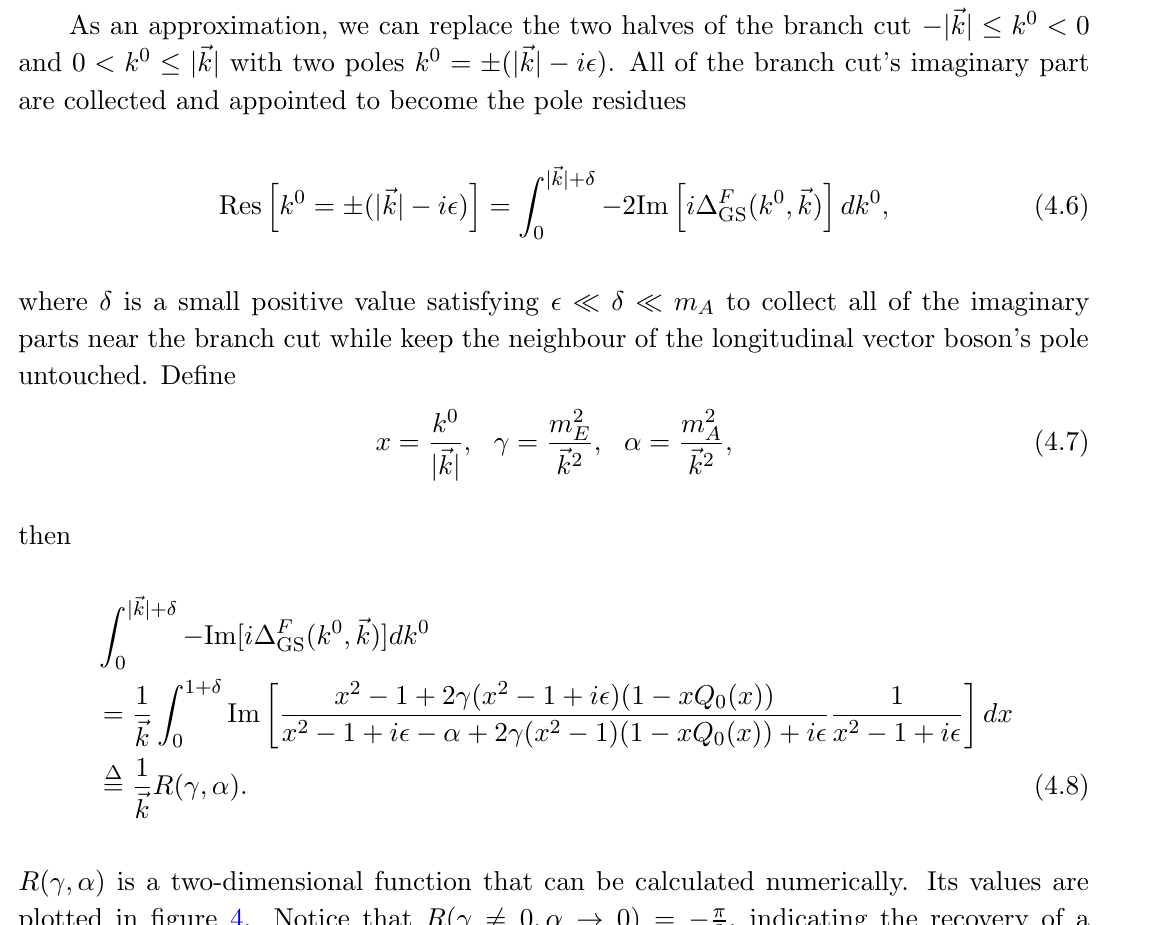
( k 0 ; j ~k j ). Notice that D F (cid:3) ( k 0 ; j ~k j ) is not the GS GS ( k 0 ; j ~k j ) through all over the complex plane. Only the branch points and GS ( k 0 ; j ~k j ) = ( D F ( k 0 ; j ~k j )) (cid:3) is restricted on the real GS GS